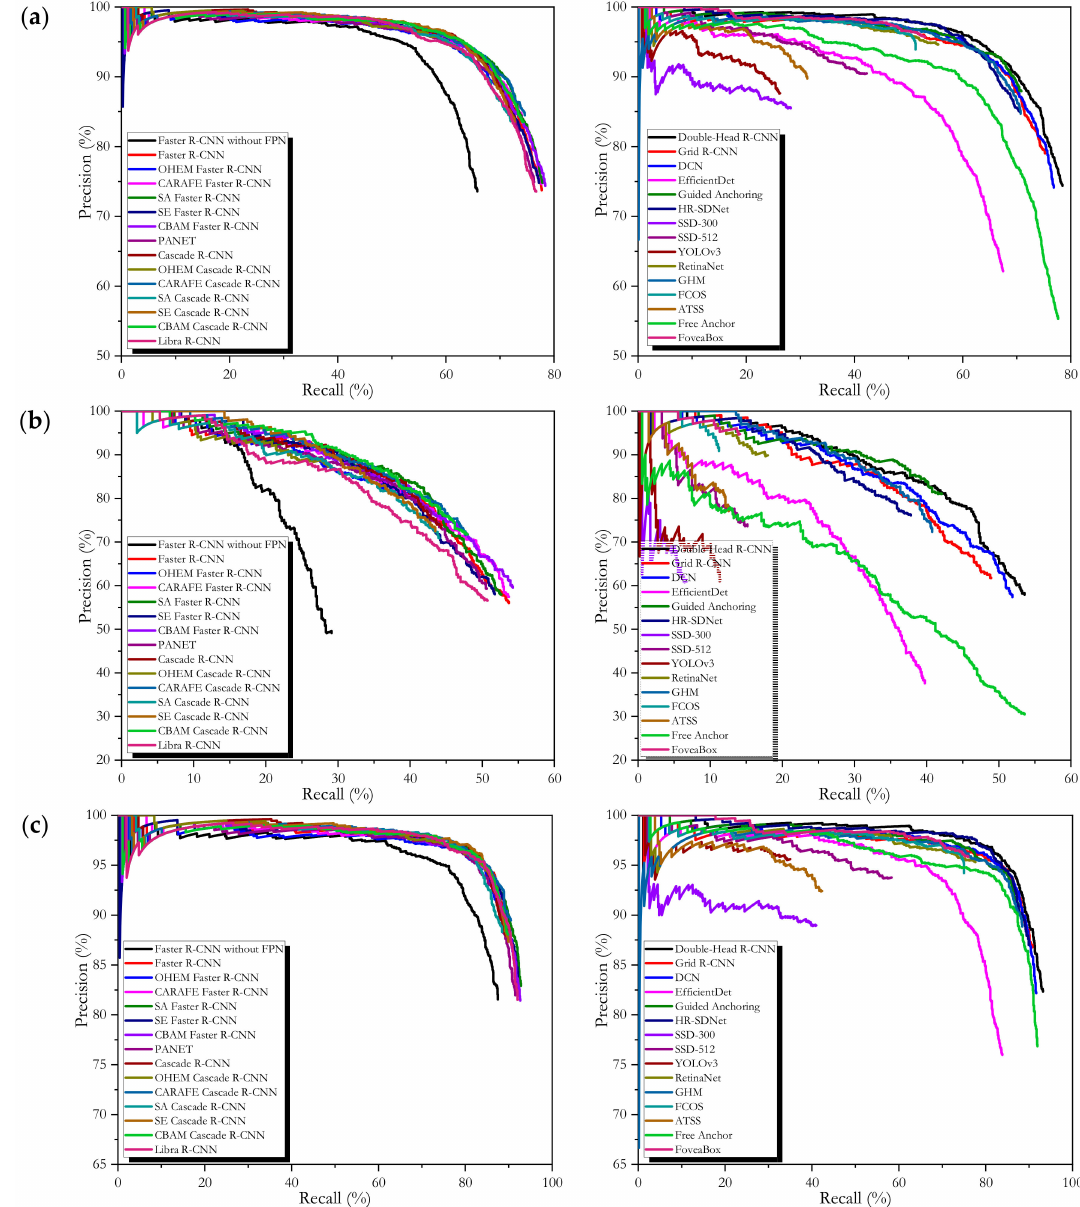
Figure 15. Precision–recall curves. ( a ) Entire scenes; ( b ) inshore scenes; ( c ) o ff shore